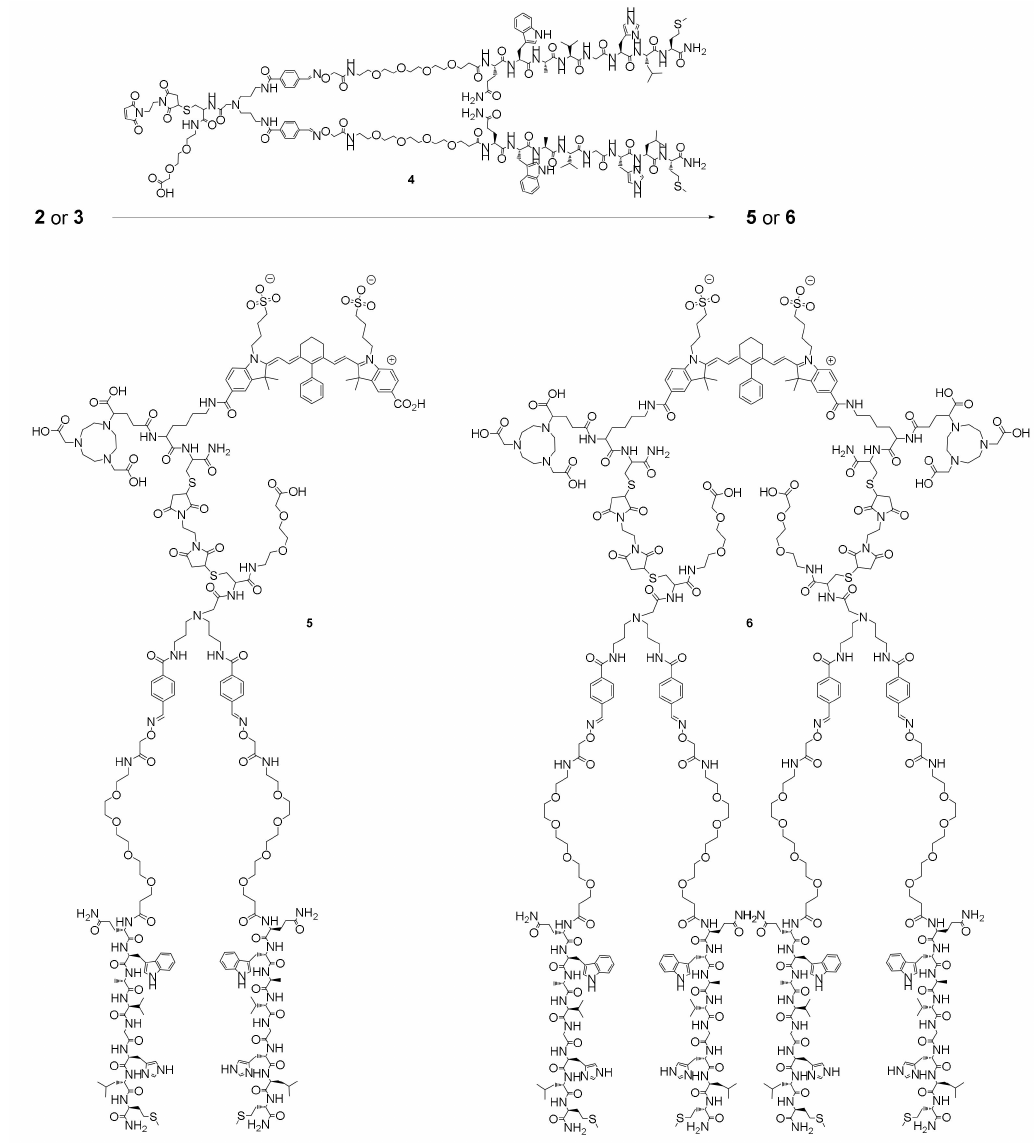
Scheme 3. Schematic depiction of the synthesis pathway to the target hybrid, chelator, and fluorescent dye-modified PESIN homodimer 5 and homotetramer 6 . Reagents and conditions: H 2 O:MeCN 1:1 ( v / v ) + 0.1% TFA + phosphate buffer (0.5